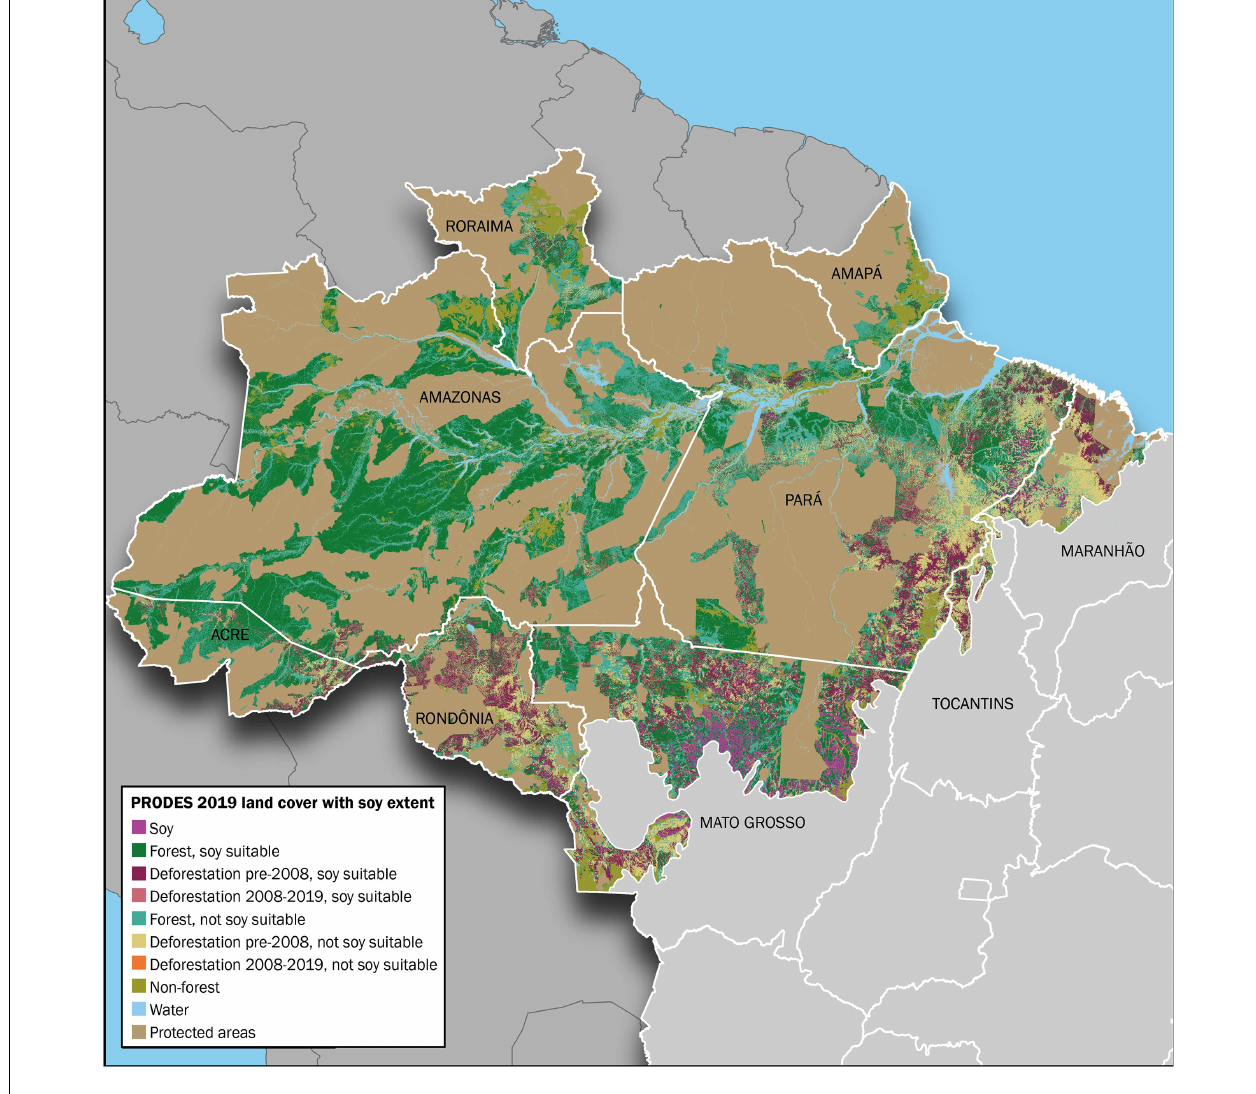
Frontiers in Forests and Global Change |